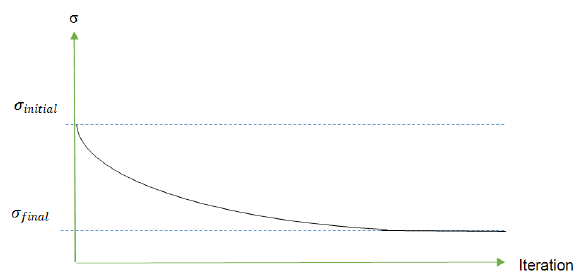
Figure 4. Regeneration respect to fitness of each standard deviation ( 𝛔